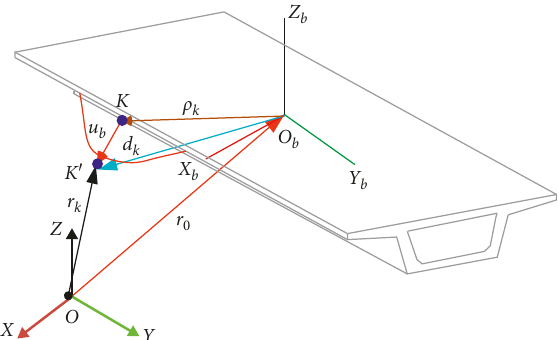
Figure 4: Floating reference frame for the long-span continuous bridge